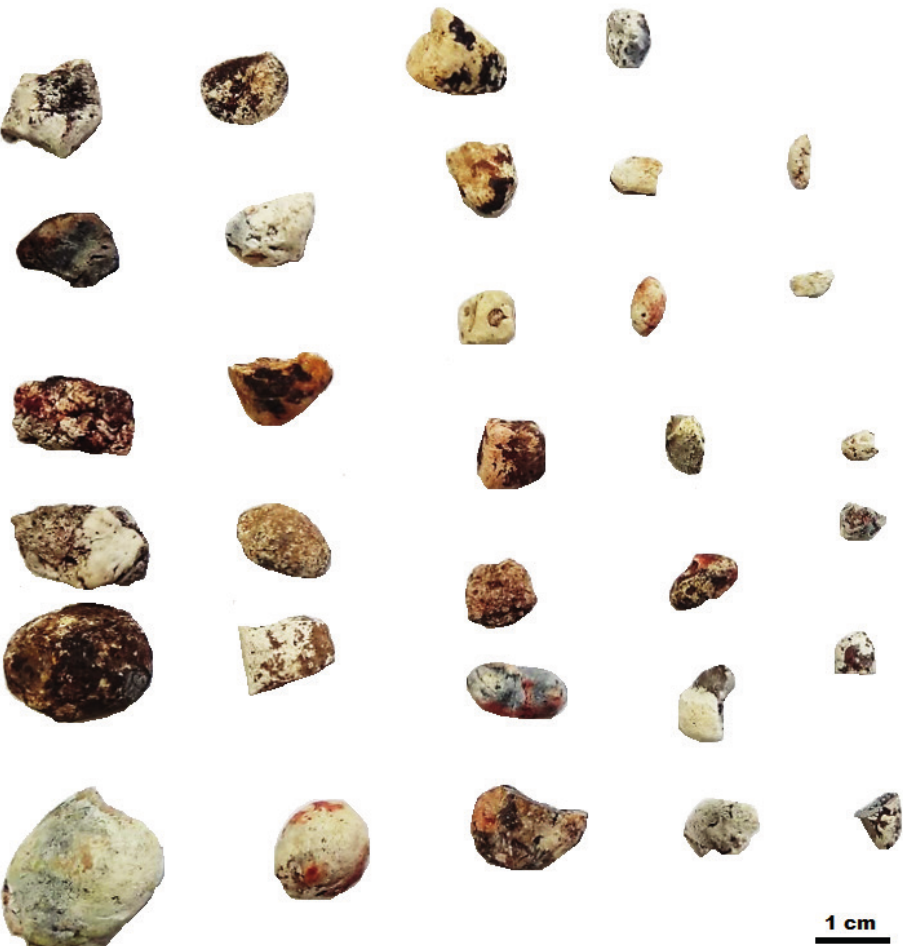
Figure 1 - Some coprolites preliminary assigned to Crocodyliformes recovered from the Bauru Group, Adamantina Formation, Santo Anastácio Municipality, São Paulo